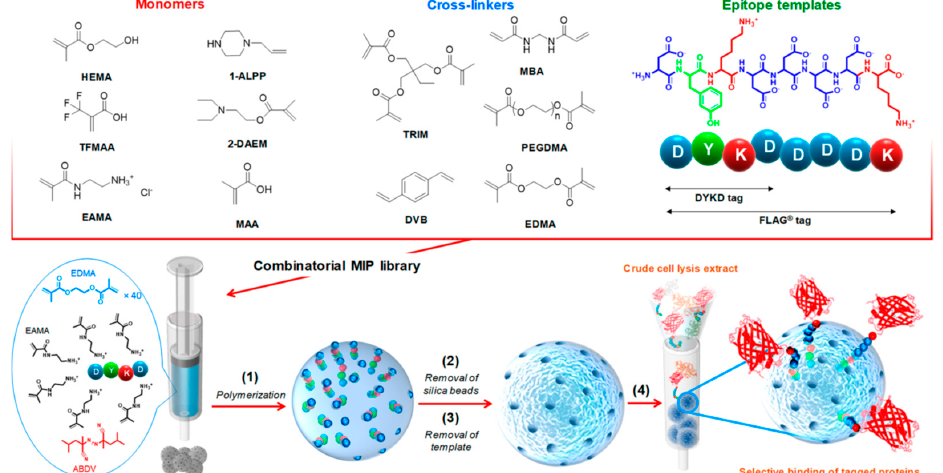
Figure 15. Workflow of the production of DYKD and FLAG tag-imprinted resins and purification of tagged mCherry-FLAG by MISPE. Reprinted from [59], with permission from American Chemical Society, 2019.